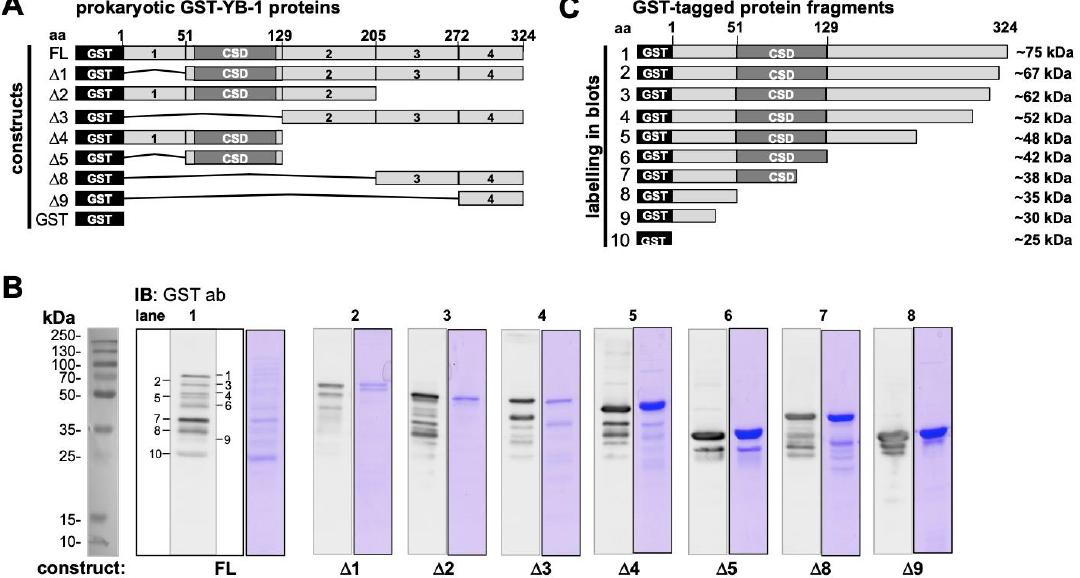
Figure 2. Characterization of spontaneous cleavage of recombinant prokaryotic YB-1 protein derivatives with a GST-tag in the protein N-terminus. ( A ). Scheme of recombinant GST-YB-1 fusion proteins with FL (0.5 µ g) reflecting full-length YB-1. ∆ 1 (0.5 µ g) lacks the N-terminal domains and presents the cold shock domain and C-terminal domains of YB-1. ∆ 2 (0.5 µ g) extends from aa 1 to 205 and lacks part of the C-terminal alternative positive and negatively charged domains 3 and 4; ∆ 3 (0.5 µ g) only consists of the charged C-terminal domains 2 through 4; ∆ 4 (1 µ g) comprises the N-terminus and the CSD; ∆ 5 (1 µ g) represents the cold shock domain; ∆ 8 (1 µ G) includes aa 208–324; ∆ 9 (1.5 µ g) reflects the rear C-terminal ending reaching from aa 272–324. ( B ) Immunoblotting of GST-YB-1 protein samples with anti-GST-antibody and Coomassie staining. GST-tag is of 25 kDa molecular size. Full-length GST-YB-1 has a relative molecular weight of 75 kDa. There are around 8 protein bands besides the GST-tag that are detected by the anti-GST antibody, which are denoted 1–5, 8, 9. ( C ) GST-YB-1 cleavage pattern based on immunoblotting.